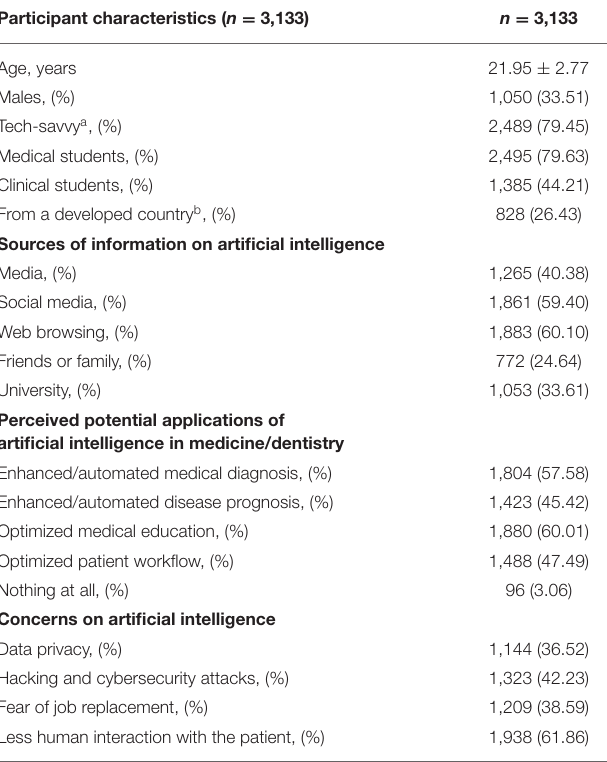
TABLE 1 | Participant demographics, sources of information on artificial intelligence (AI), perceived potential applications of AI in medicine/dentistry, and concerns on